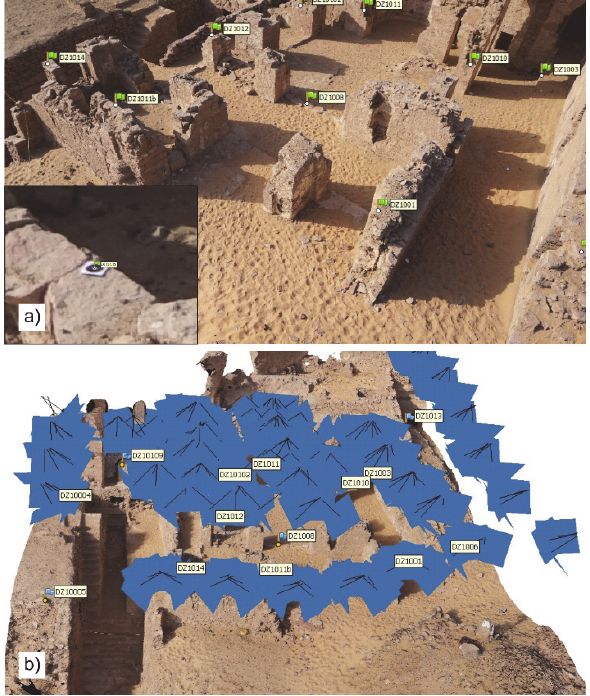
Figure 4. a) View of targets distribution over the scene; b) view of photograph distribution obtained after the orientation